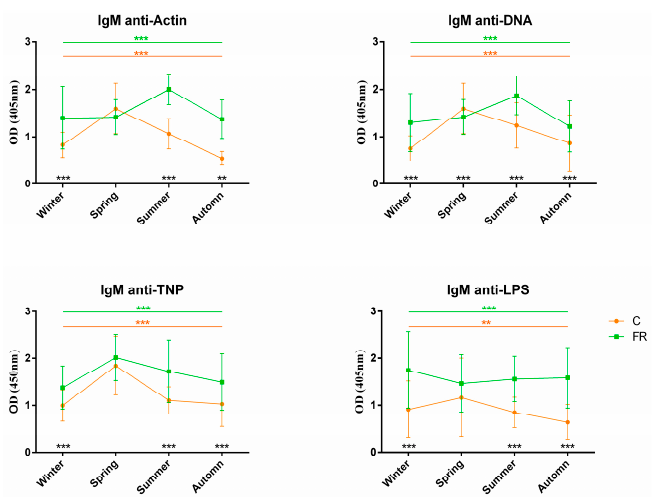
Figure 3. IgM NAb levels for fast- and slow-growth broilers across seasons: IgM NAb levels for the FR (Sasso, n = 210) and C (Ross 308, n = 210) groups were estimated by the binding capacity of serum NAbs to actin, DNA, TNP and LPS. OD values (mean ± SD) are given on the y axis for each year, with season on the x axis. Colored asterisks indicate significant differences among seasons for every genotype, while black asterisks indicate significant differences between the two genotypes ( p < 0.01 **, p < 0.001 ***).